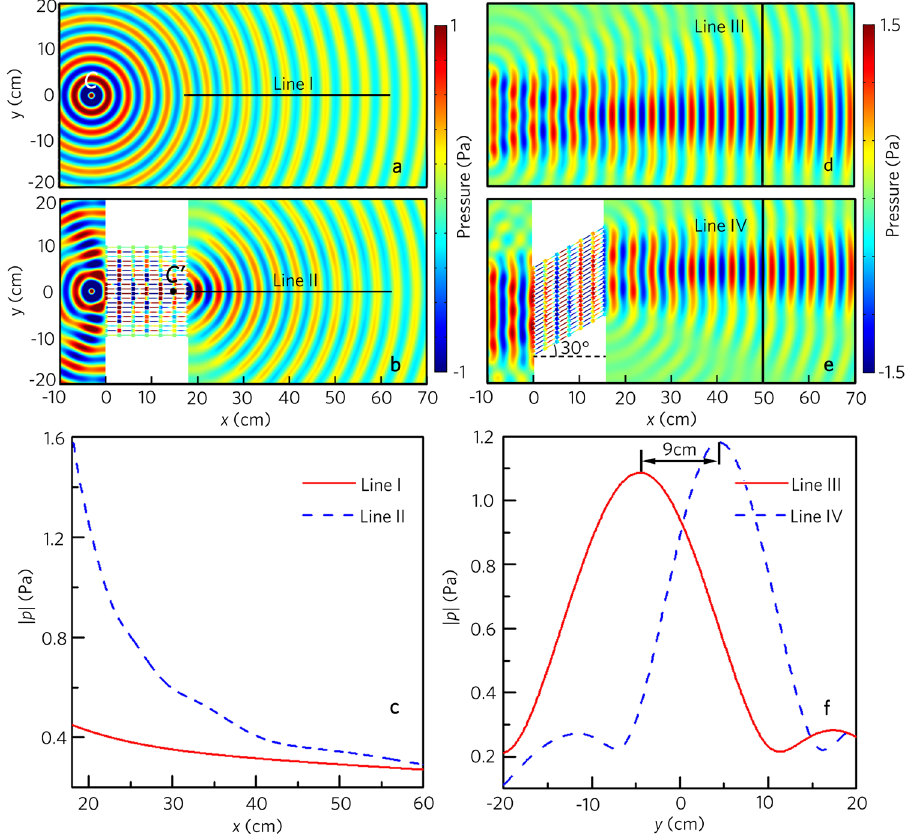
Figure 4. Acoustic invisibility performances. Simulated acoustic pressure field distributions ( a ) without and ( b ) with the acoustic metafiber bundle illuminated by an incident cylindrical wave at 8.0 kHz. The cylindrical acoustic source is located at ( − 3 cm, 0) in Cartesian coordinates. ( c ) Pressure amplitude distributions along the lines I and II in ( a and b ). Simulated acoustic pressure field distributions ( d ) without and ( e ) with the acoustic metafiber bundle illuminated by the normally plane wave at 8.0 kHz, and the acoustic metafiber bundle in e is rotated 30°. ( f ) Pressure amplitude distributions along the lines III and IV in ( d and e